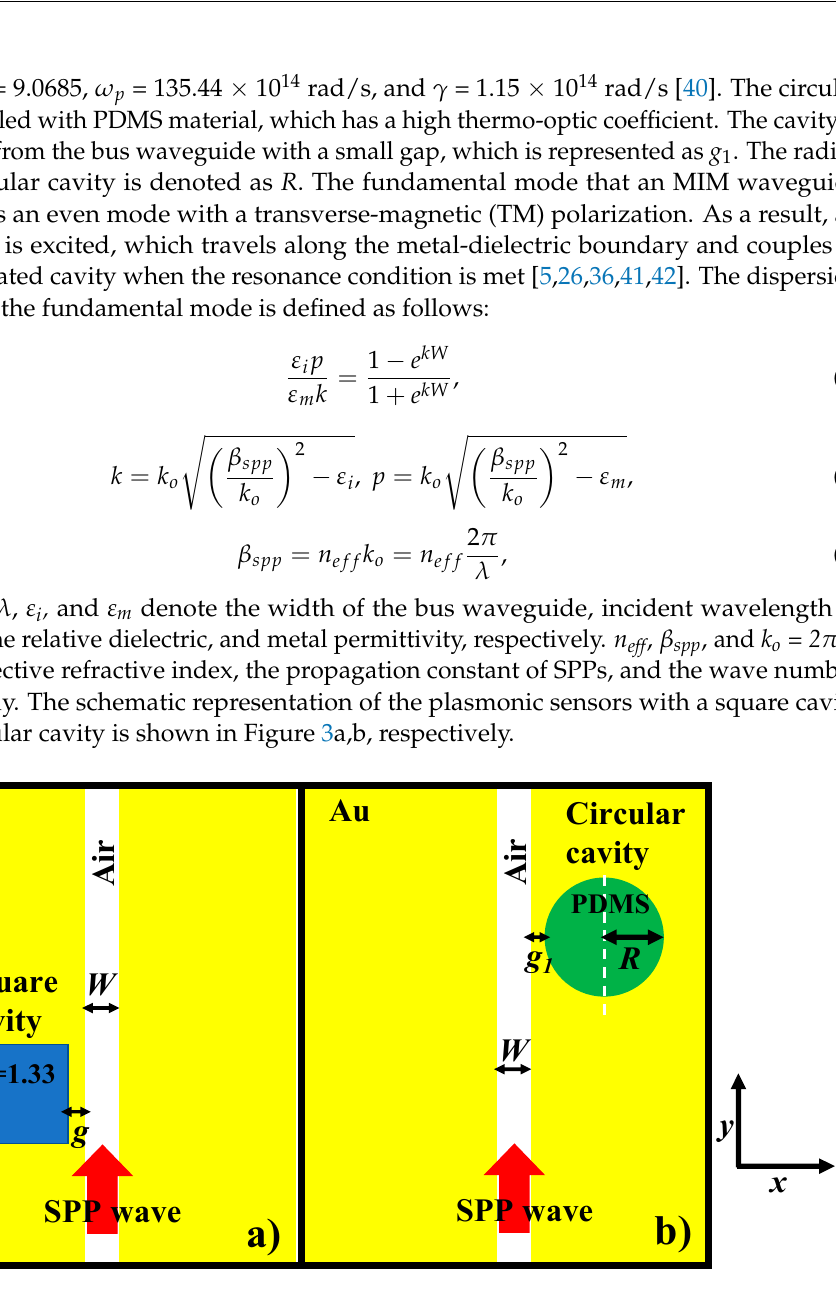
Figure 3. Schematic representation (top view) of the plasmonic cavity coupled to a bus waveguide: ( a ) square cavity filled with dielectric medium, n = 1.33, and ( b ) circular cavity filled with thermo-optic material, PDMS.